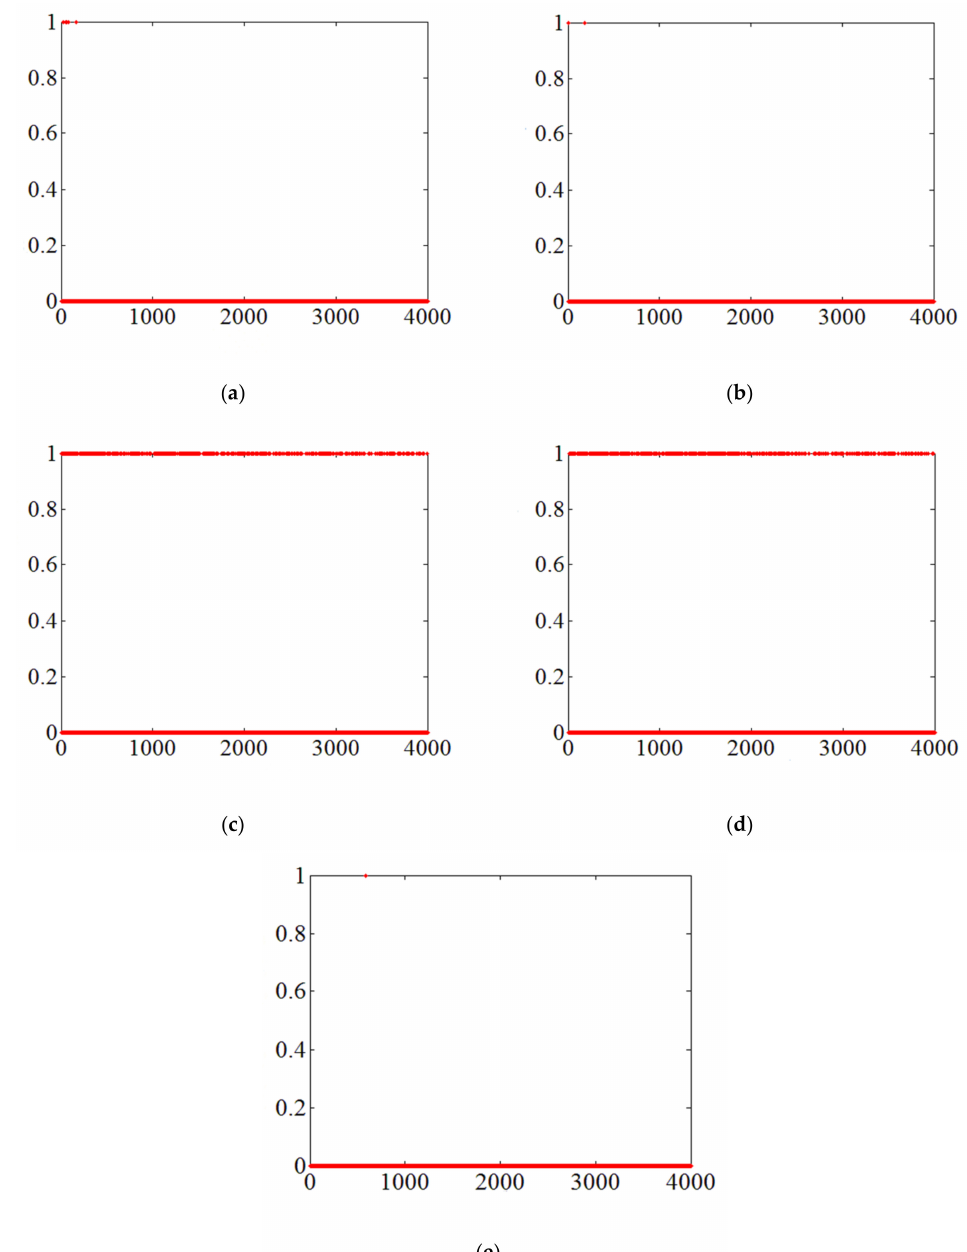
Figure 6. Acceptance rates of different operations during iteration: ( a ) The acceptance rate of add polygons; ( b ) The acceptance rate of delete polygons; ( c ) The acceptance rate of add polygon nodes; ( d ) The acceptance rate of delete polygon nodes; ( e ) The acceptance rate of merging